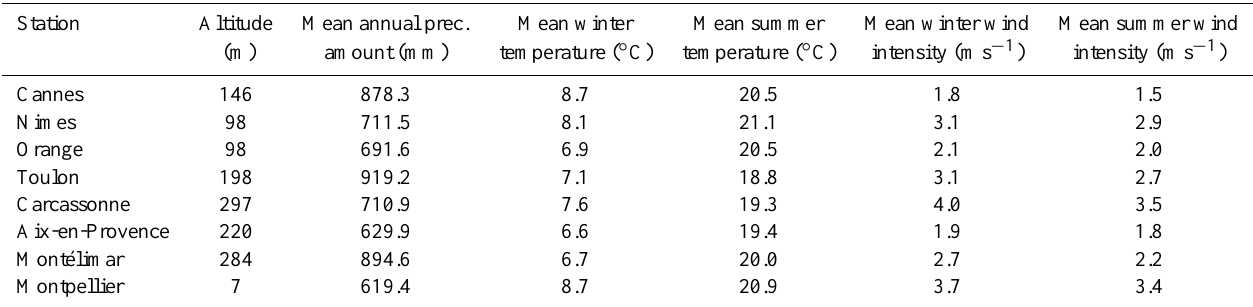
Table 1. Main characteristics of the eight stations over the 1981–2000 period for rainfall and temperature and over the 1991–2000 period for wind